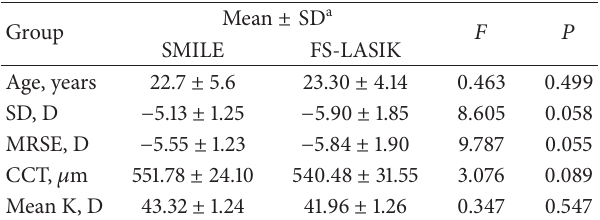
Table 1: Preoperative patients characteristics.